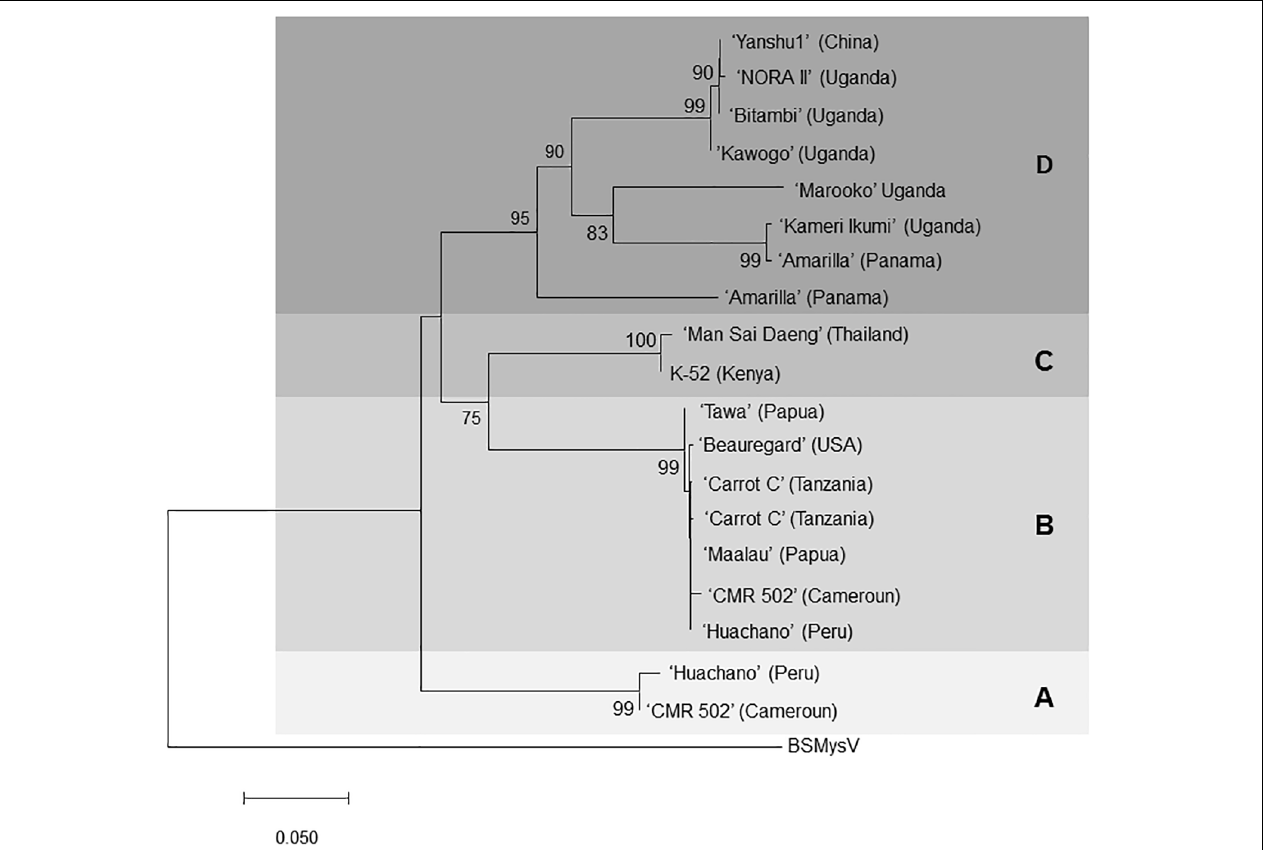
FIGURE 2 | Phylogenetic tree of SPPV sequences covering the reverse transcriptase and Rnase H domains amplified from sweet potato accessions from around the world. The evolutionary history was inferred by using the minimum evolution method, and the evolutionary distances were computed using the maximum composite likelihood method and are in the units of the number of base substitutions per site. The optimal tree with the sum of branch length = 1.15686856 is shown. and is drawn to scale, with branch lengths in the same units as those of the evolutionary distances used to infer the phylogenetic tree. The percentage of trees in which the associated taxa clustered together is shown next to the branches based on 500 bootstrap replications when larger than 70%. The ME tree was searched using the close-neighbor-interchange algorithm at a search level of 1. The neighbor-joining algorithm was used to generate the initial tree. The analysis involved 20-nucleotide sequences. All ambiguous positions were removed for each sequence pair. There were a total of 828-nt positions in the final data set. Evolutionary analyses were conducted in MEGA7 (Lodhi et al., 1994). Isolates are indicated by the name of the variety from which they were amplified, and the origin of the variety is provided in brackets for each of them. BSMYV (banana streak MY virus) was used as an outgroup for phylogenetic tree construction. Four phylogenetic groupings A, B, C, and D are highlighted in different shades of gray.